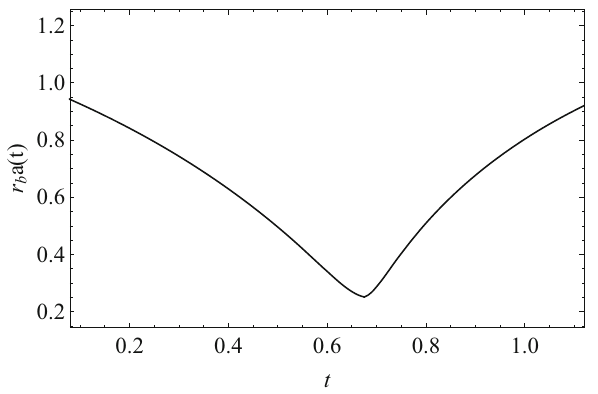
Fig. 1 The physical radius of the boundary R b ( t ) = r b a ( t ) as a function of the co-moving time with a ( t ) = a I ( t I ) for t ≤ t B and a ( t ) = a II ( t II ) for t ≥ t B . The bounce occurs at the critical scale given by a I ( t B ) = a II ( t B ) . The values of the parameters are k I = 1 . 5, m I = 2 and k II = 1 . 96, m II = 3, ω = 1 / 3 for the collapsing and the expanding part